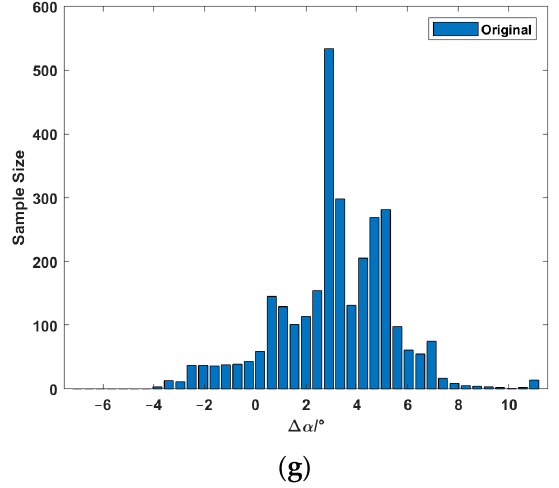
Figure 7. Comparisons of the prediction of the angle of attack. ( a ) Histogram of the prediction error of α for the network optimized by the GA with f 1 . ( b ) Histogram of the prediction error of α for the network optimized by the GA with f 2 . ( c ) Histogram of the prediction error of α for the network optimized by the GA with f 3 . ( d ) Histogram of the prediction error of α for the network optimized by PSO with f 1 . ( e ) Histogram of the prediction error of α for the network optimized by PSO with f 2 . ( f ) Histogram of the prediction error of α for the network optimized by PSO with f 3 . ( g ) Histogram of the prediction error of α for the network without optimization. Table 2. Error comparison for the angle of attack prediction.